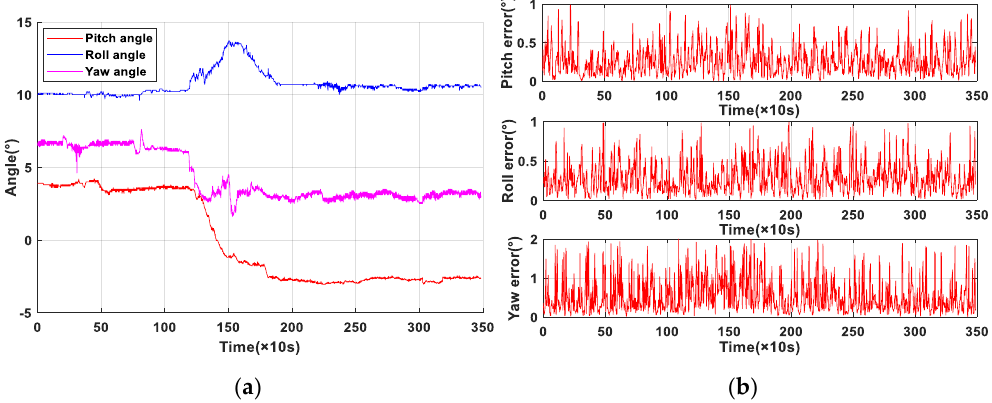
Figure 10. Industrial application results of support attitude sensing system-based GD-UKF: ( a ) attitude angle estimation; ( b ) estimation error.